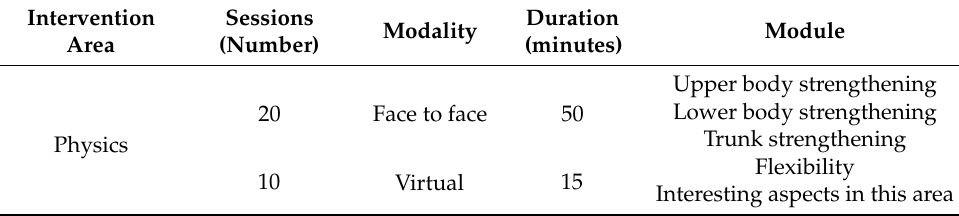
Table 1. Session